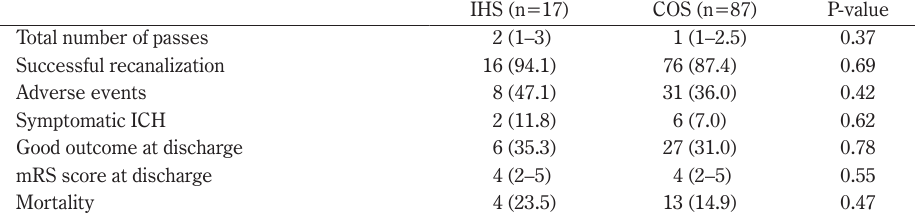
Figure 1 Comparison of treatment time intervals between the IHS and COS groups. Box-and-whisker plots of the time from (A) door to computed tomography (CT), (B) door to puncture, (C) CT to puncture, and (D) puncture to reperfusion. The horizontal line within the box represents the median and the top and bottom edges of each box indicate the interquartile range. Door-to-CT and door-to-puncture times were significantly longer in the IHS group than the COS group. * Significant difference with P<0.05. ** Significant difference with P<0.01. COS, community-onset stroke; IHS, in-hospital stroke; LWK, last well known Table 3 Comparison of treatment outcomes between the in-hospital stroke and community-onset stroke